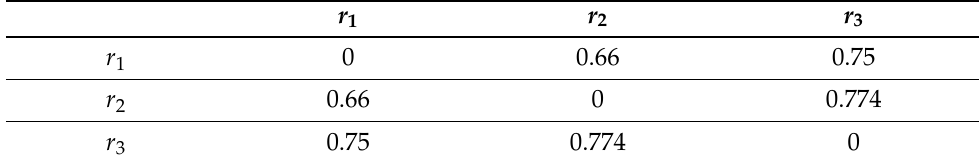
Table 6. Distances between reserves measured with